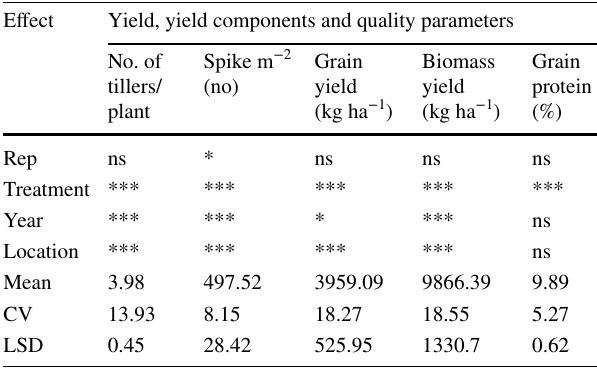
Table 5 Analysis of variance of treatment effects on yield, yield com- ponents and grain quality of malting barley at Lemu-Bilbilo district in southeastern Ethiopian